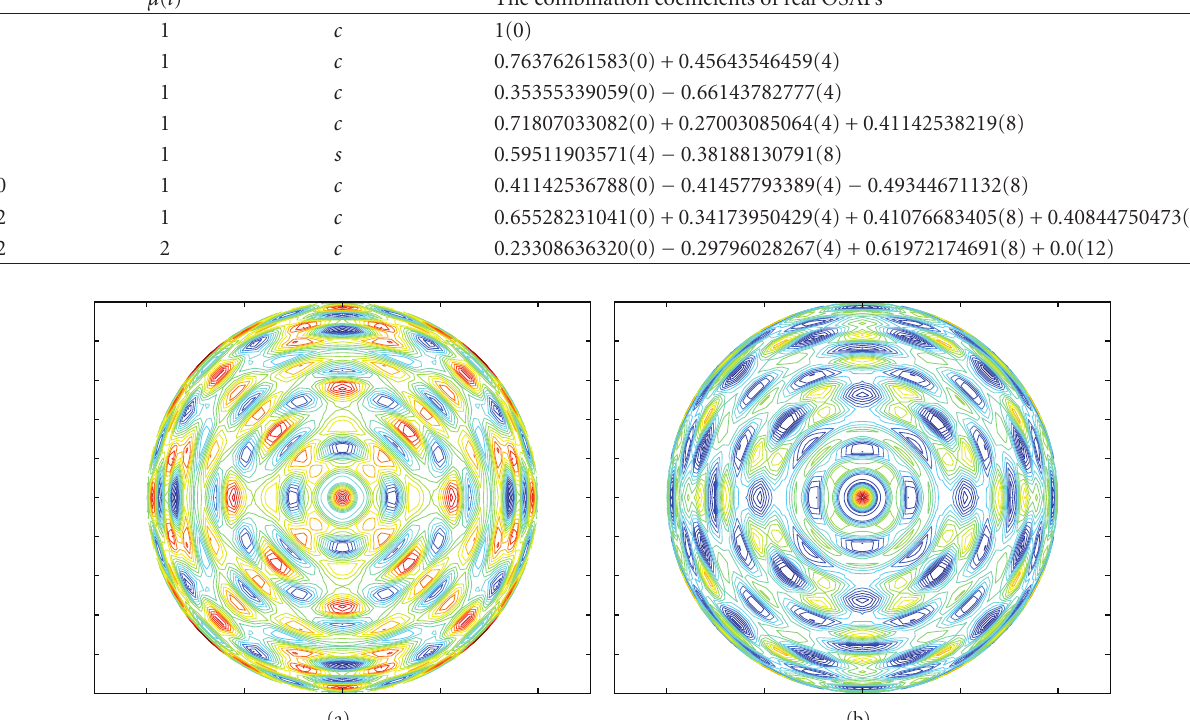
Figure 1: Density contour maps of the OSAFs looking down along a fourfold axis. (a) l = 40, μ = 1, (b) l = 40, μ =